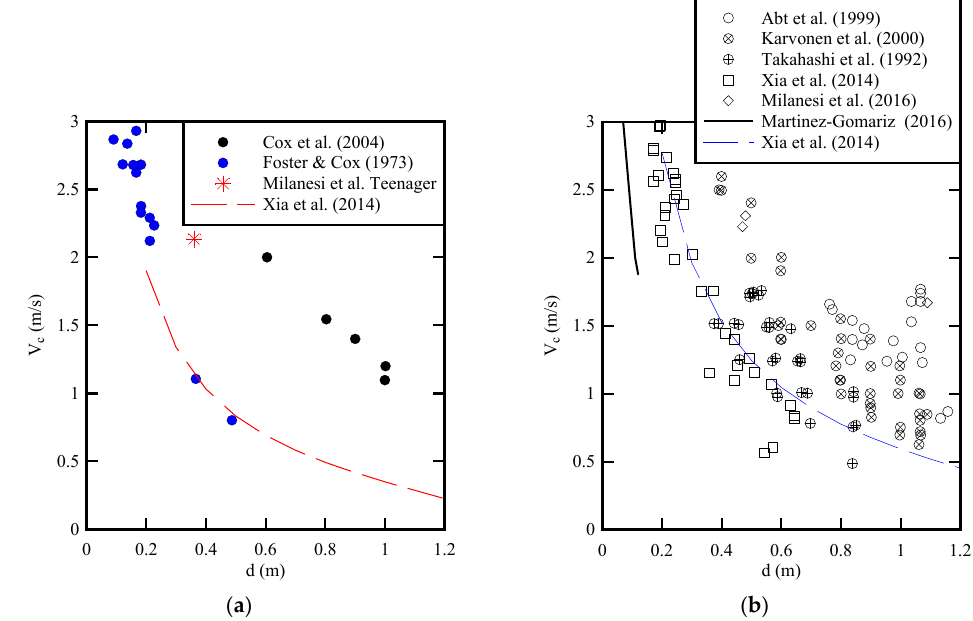
Figure 2. Relationship between characteristic flow velocity and water depth for stability of ( a ) children and ( b ) adults. Comparison between field data [27], full-scale tests [11,17–19,23], scaled model data of [12], and semi-analytical relationship proposed by [12].